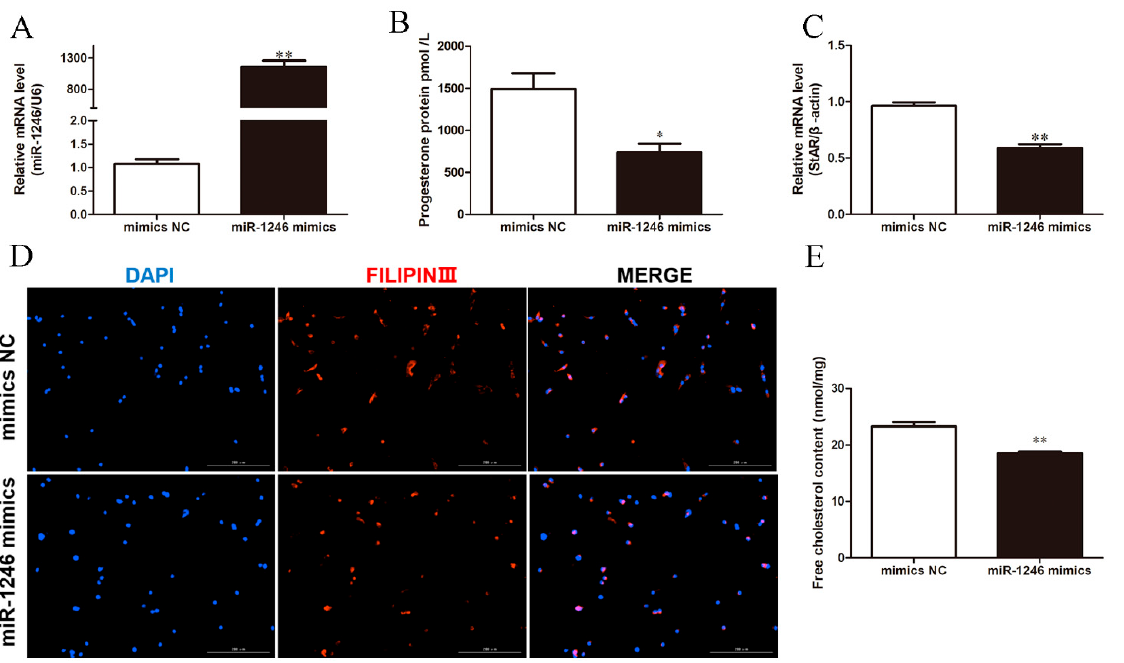
Figure 2. Overexpression of miR-1246 reduces P4 synthesis in BGCs. ( A ) The level of P4 in BGCs. ( B, C ) The relative mRNA expression of StAR and miR-1246 in BGCs. ( D ) Representative filipin staining of BGCs. ( E ) Relative content of free cholesterol in BGCs. Mimics NC, negative control of miR-1246 mimics; miR-1246 mimics, overexpression of miR-1246. All data were presented as the mean ± SD ( n = 3), * p < 0.05, ** p < 0.01.